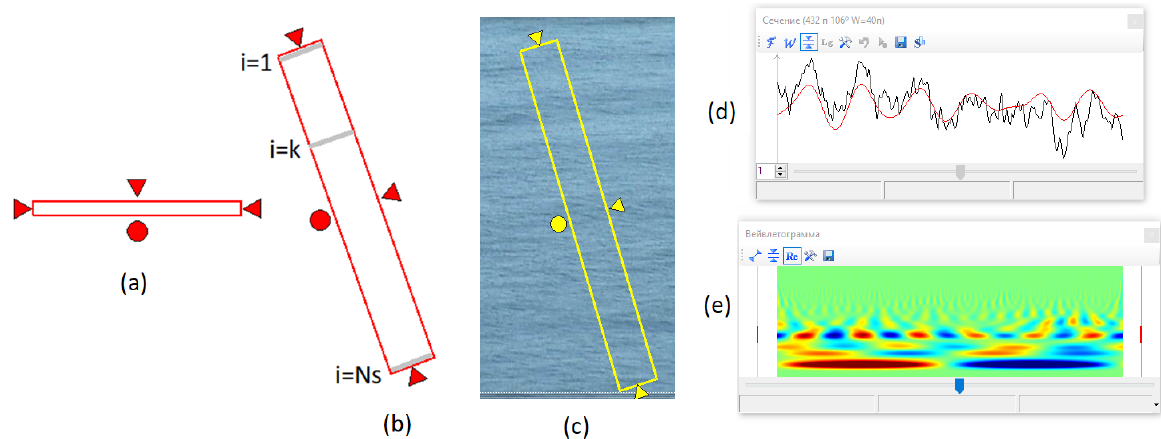
Figure 6. Transect tool: ( a ) basic selector; ( b ) stretched selector with a transect calculation scheme S ( i ) , i = 1, N s ; ( c ) example of transect installation on a sea scene; ( d ) waveform of transect; ( e ) Waveletogram of transect.